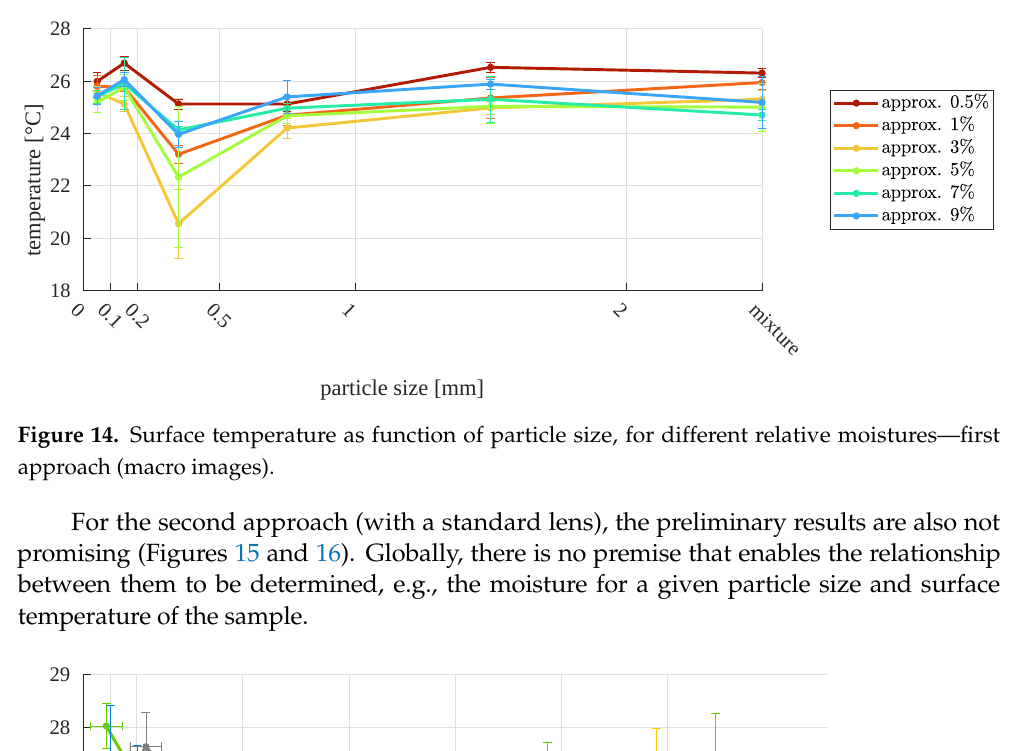
Figure 13. Surface temperature as a function of relative moisture, for different particle sizes—first approach (macro images).